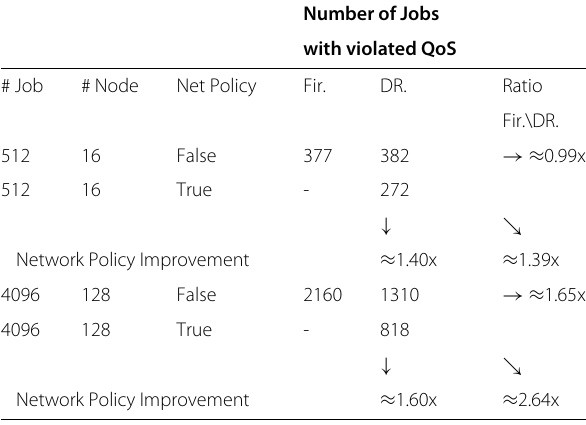
Table 5 Number of jobs with violated QoS